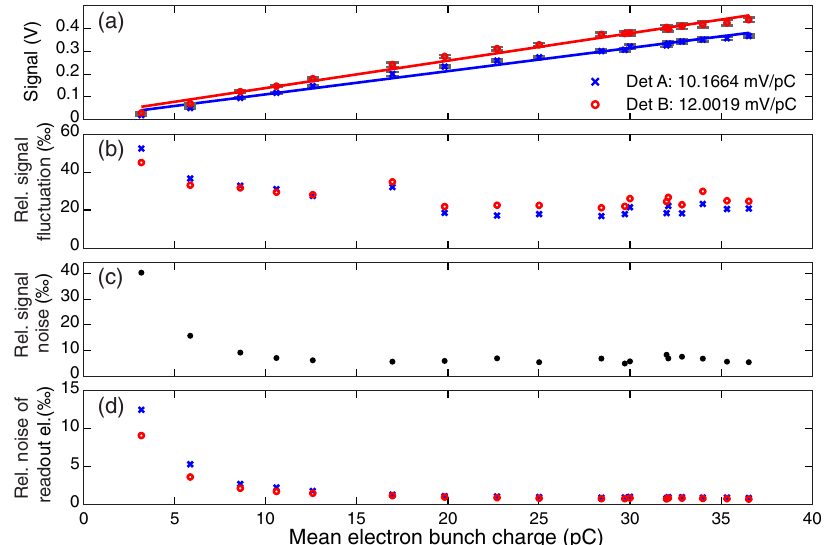
FIG. 49. Detector signals for two identical THz filters (a), relative signal fluctuation (b), detector signal noise as calculated from the correlation from the two detection channels (c), and noise contribution from read-out electronics (d), all shown as a function of the electron bunch charge.